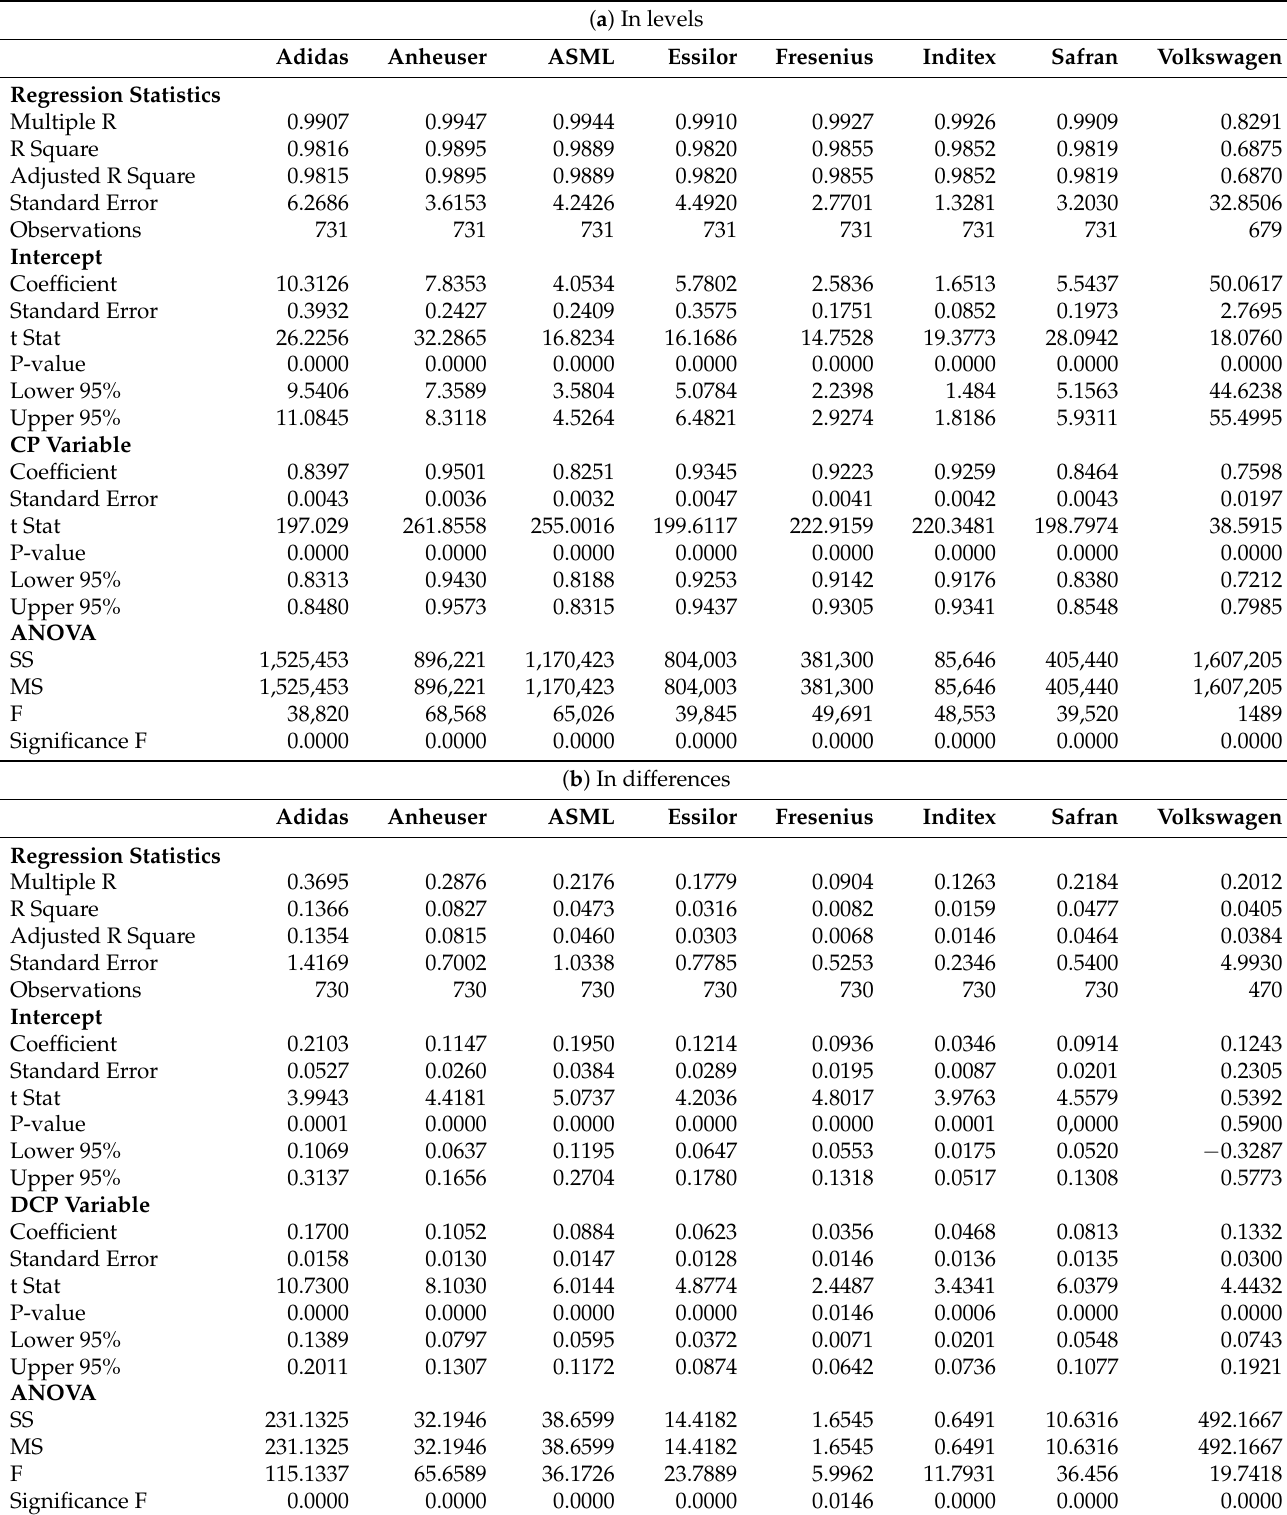
Table 7. Target prices vs. capitalised prices: individual asset results. Individual regressions of target prices (FP)